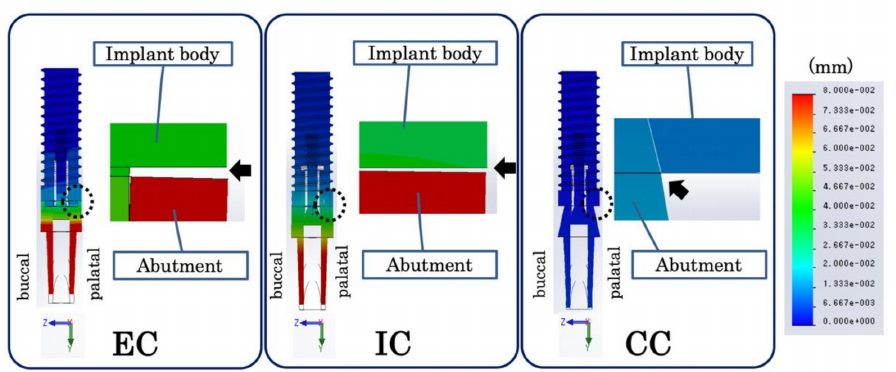
Figure 8. ( a ) Microgap measurement on a cross-sectional view of the implant component in the buccopalatal direction. The figure on the right is an enlargement of the region indicated by the dotted line. The black arrow indicates the microgap on the palate side of the interface between the implant body and the abutment. EC: external connection; IC: internal connection; CC: conical